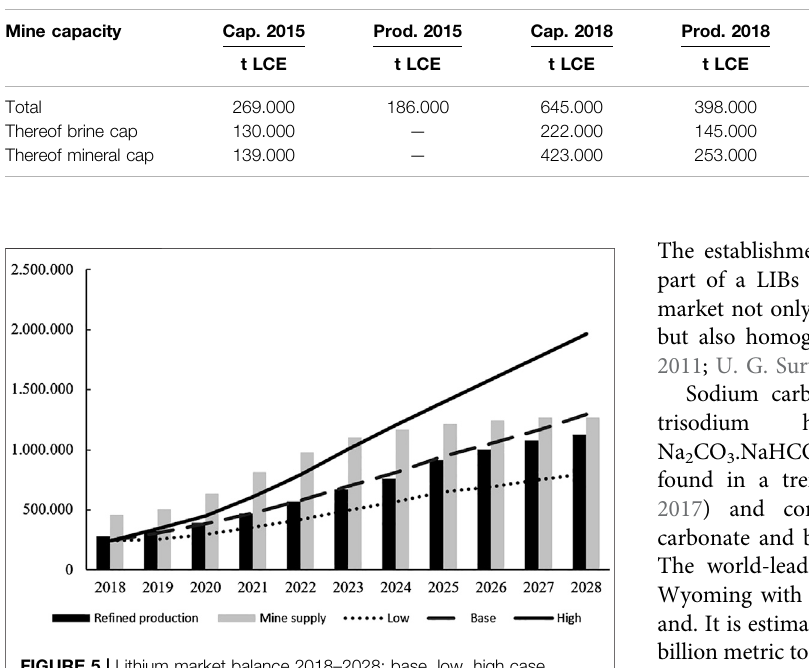
Frontiers in Energy Research |